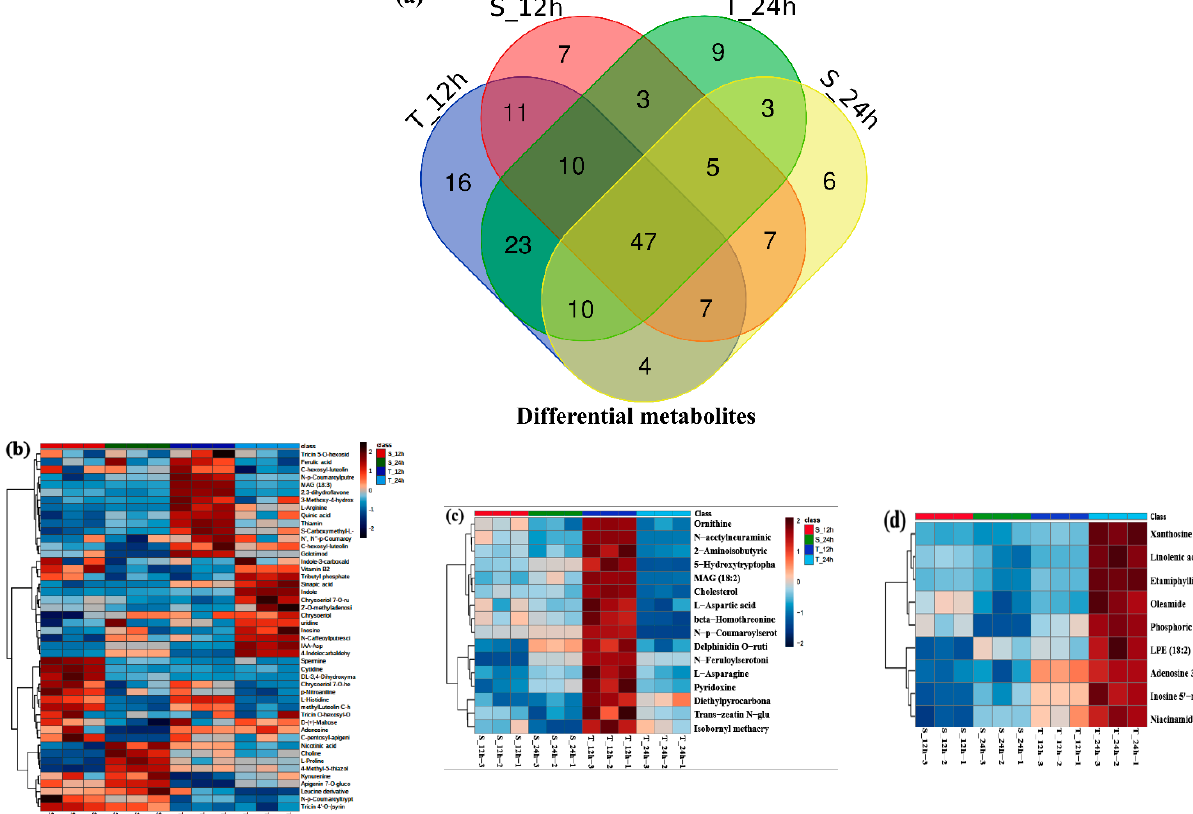
Figure 7. Differential metabolites of Yangyou 9 (T) and Zhengsheng 11 (S), fold change >1. ( a ) Venn diagram and ( b ) heatmaps of differential metabolites during 12 and 24 h of germination under salt treatment for tolerant (T) and sensitive (S) cultivar. Heatmaps of differential metabolites in tolerant cultivar after ( c ) 12 h and ( d ) 24 h of germination under salt treatment.